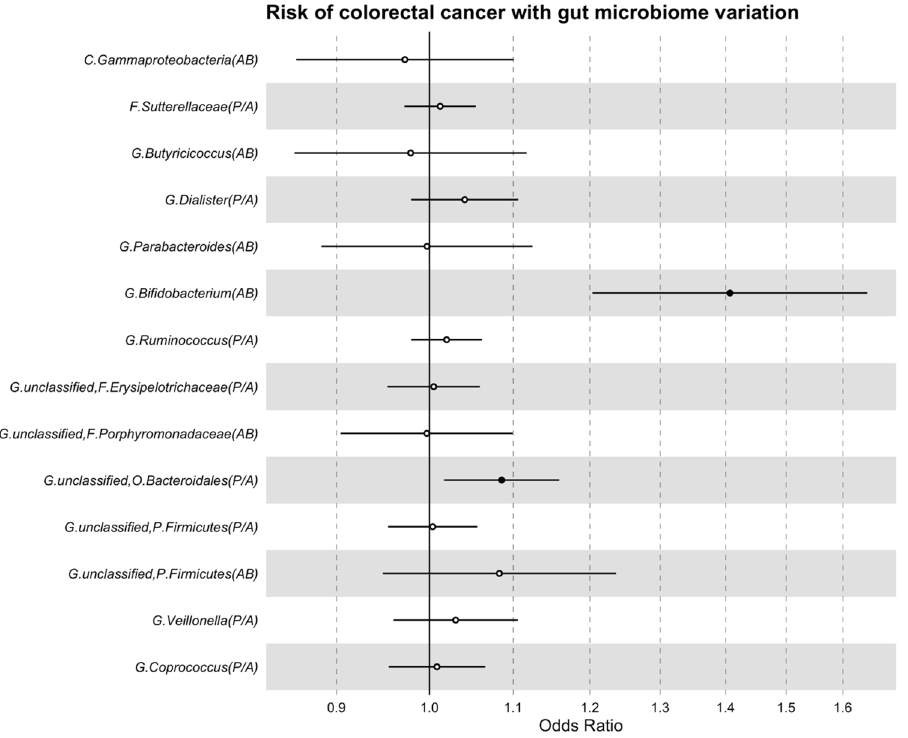
Figure 2. MR estimates of the effect of each microbial trait on overall CRC risk. AB = abundance; CI = confidence interval; CRC = colorectal cancer; MR = Mendelian randomization; OR = odds ratio; P/A = presence versus absence; SD = standard deviation. Letters in the microbial trait name represent the taxon classification level from which that microbial trait was observed, with “C”, “F”, “G”, “O” and “P” representing “class”, “family”, “genus”, “order” and “phylum”, respectively. All microbial traits that were not confidently classified at the genus level were organised into unclassified groups within higher classification levels (represented by “unclassified”). MR estimates represent the OR for CRC risk and 95% CI per SD unit change for continuous microbial traits (labelled as “AB” in brackets) or per approximate doubling of the genetic liability to presence (versus absence) of each binary microbial trait (labelled as “P/A” in